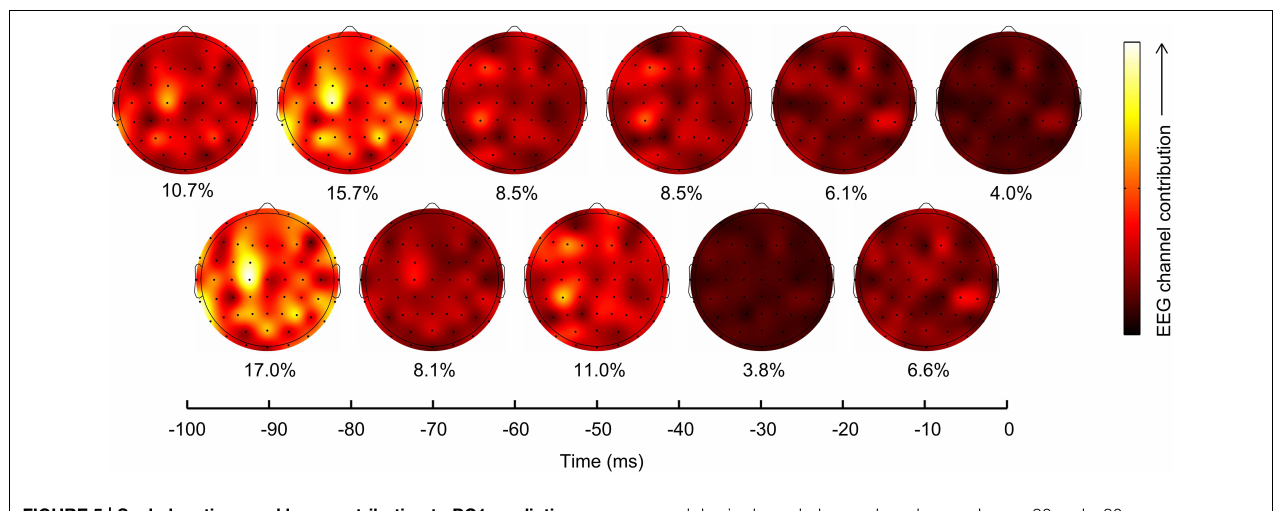
each lag is shown below each scalp map. Lags − 90 and − 80ms contributed maximally, particularly with EEG channels C1, FC1, P1, and P3. Channel CP5 was also a major contributor at other lags. Interestingly, all these channels lie above the known contralateral motor areas of the cortex.